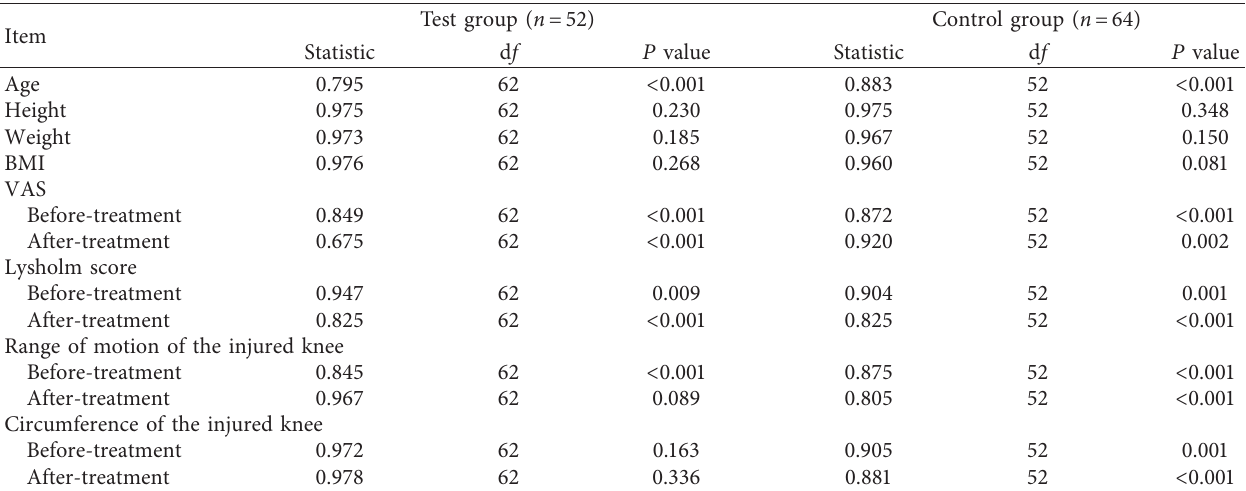
Figure 3: Flow chart of this study. The control group received conventional US therapy. The test group received a US therapy with the coupling agent substituted by VOO and VOCR as media. Table 1: Normality test